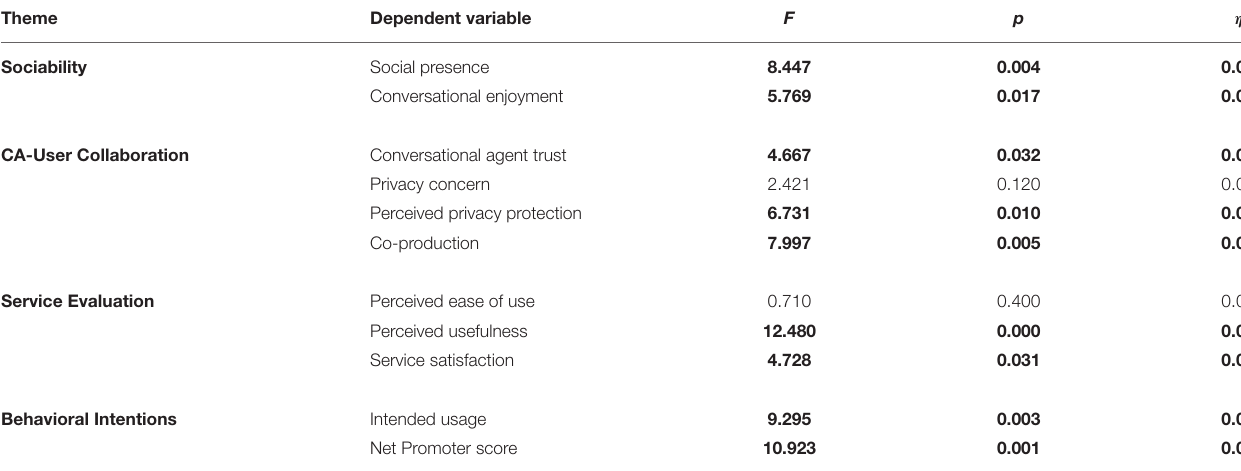
TABLE 4 | ANCOVA models results for four-way interaction between T/V Distinction, language, gender, and age per outcome variable.